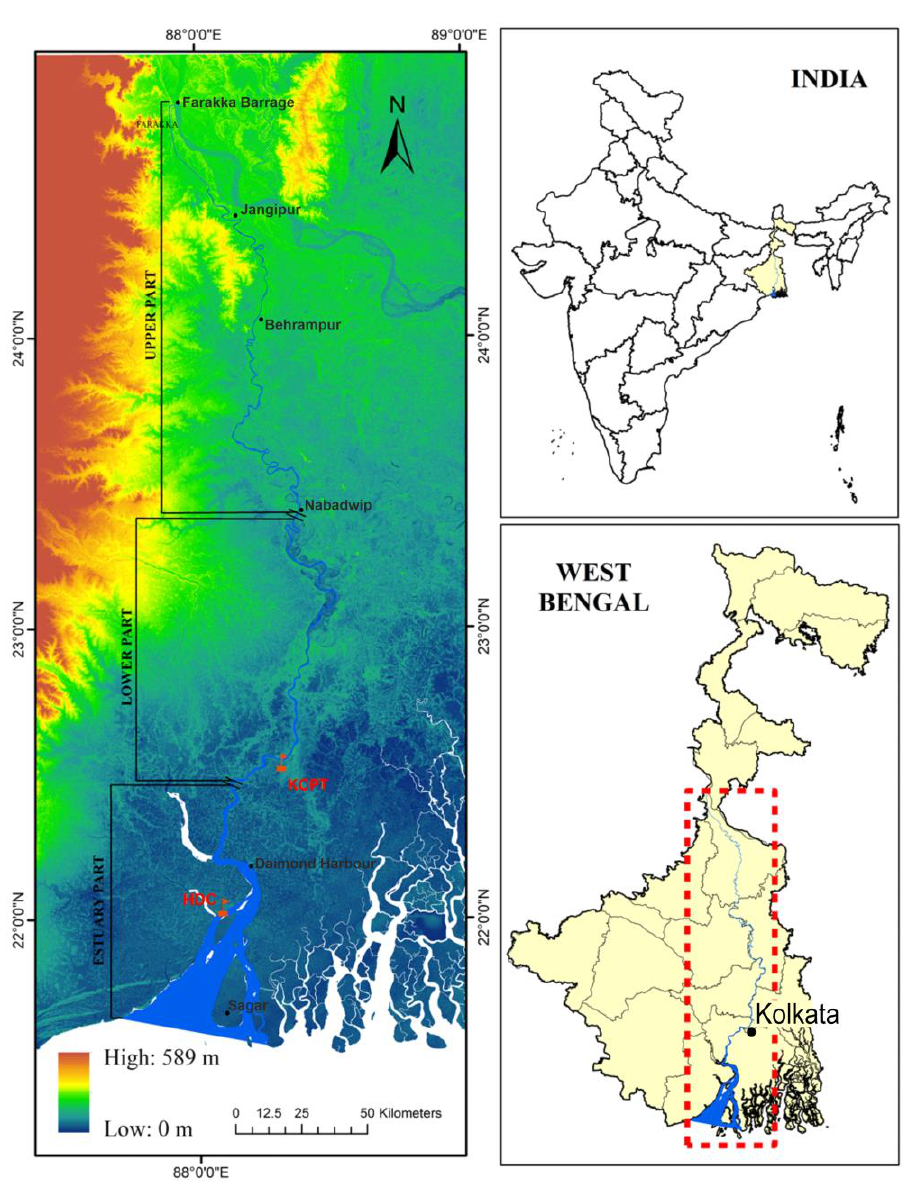
Figure 1. Map showing the study area of River Bhagirathi - Hugli with selected sections for the current study.